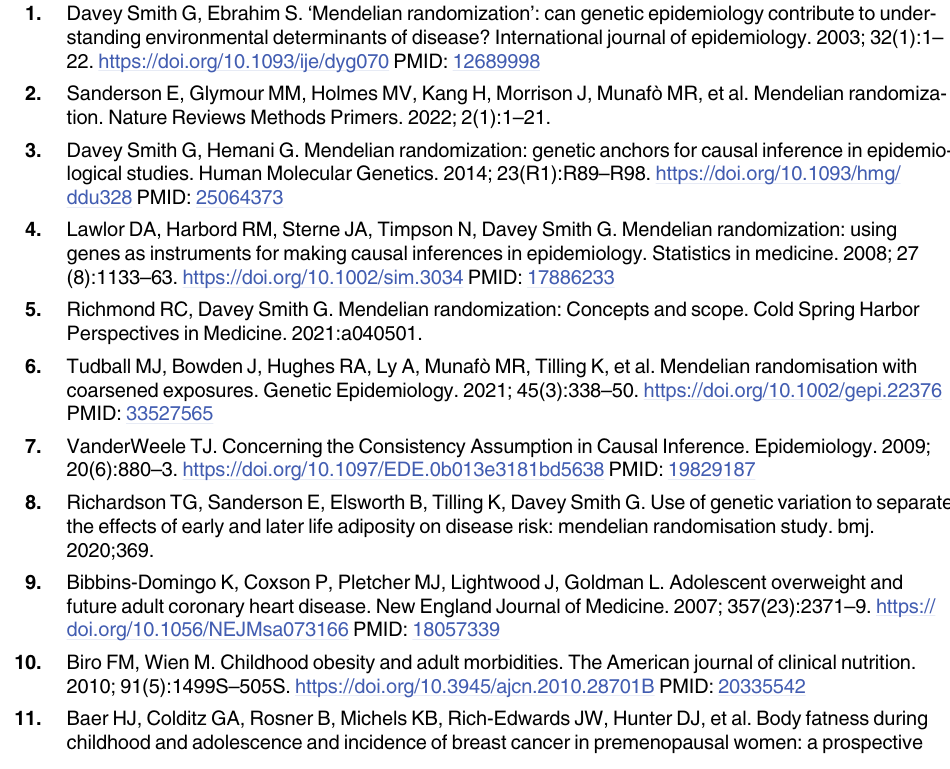
S1 Text. Supplementary material. Table B–No direct causal effect of X simulation results for a model with three exposure